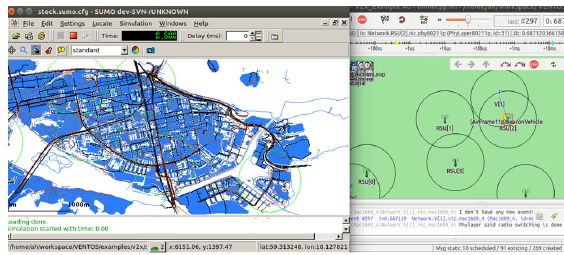
Fig. 19. Scenario 5: Simulation of 6 RSUs Fig. 20. Scenario 5: Messages are Dropped since they are coming from Untrusted